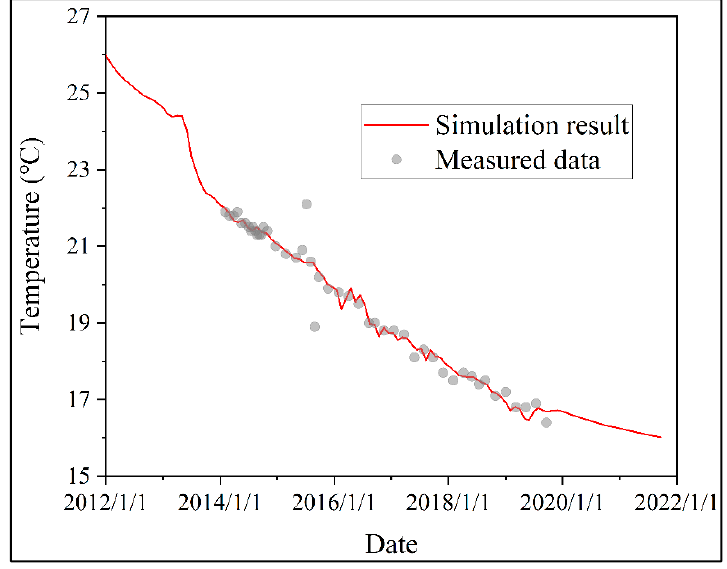
Figure 17. Temperature progress at the dam foundation.